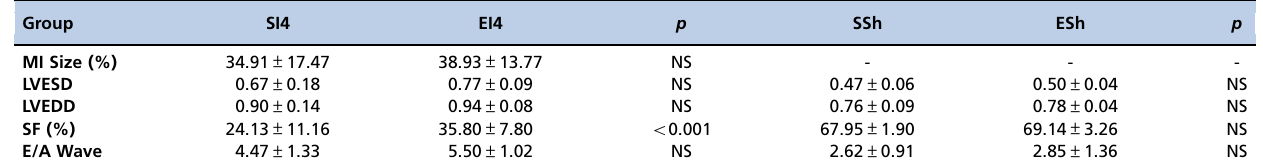
LVESD: Left Ventricular End-Systolic Diameter; LVEDD: Left Ventricular End-Diastolic Diameter; SF: Shortening Fraction.